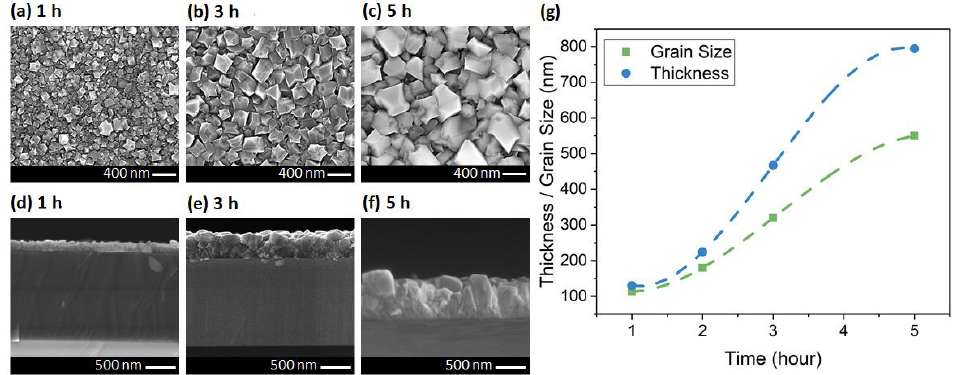
Figure 5. Plan- and cross-sectional-view SEMs of the diamond layer at ( a , d ) 1, ( b , e ) 3, and ( c , f ) 5 h. ( g ) The relationship between thickness / grain size and the growth time (lines are guides to the eye only).